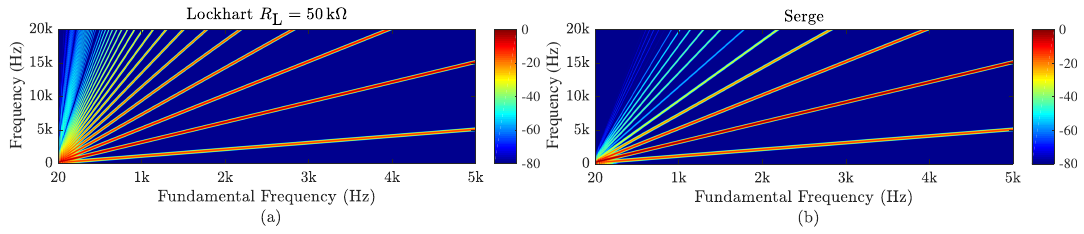
Figure 12. Spectogram for a linear sweep from 20Hz to 5kHz processed using: ( a ) the proposed Lockhart wavefolder model ( R L = 50k Ω ); and ( b ) the proposed Serge wavefolder model. A sample rate F s = 1MHz was used to simulate analog